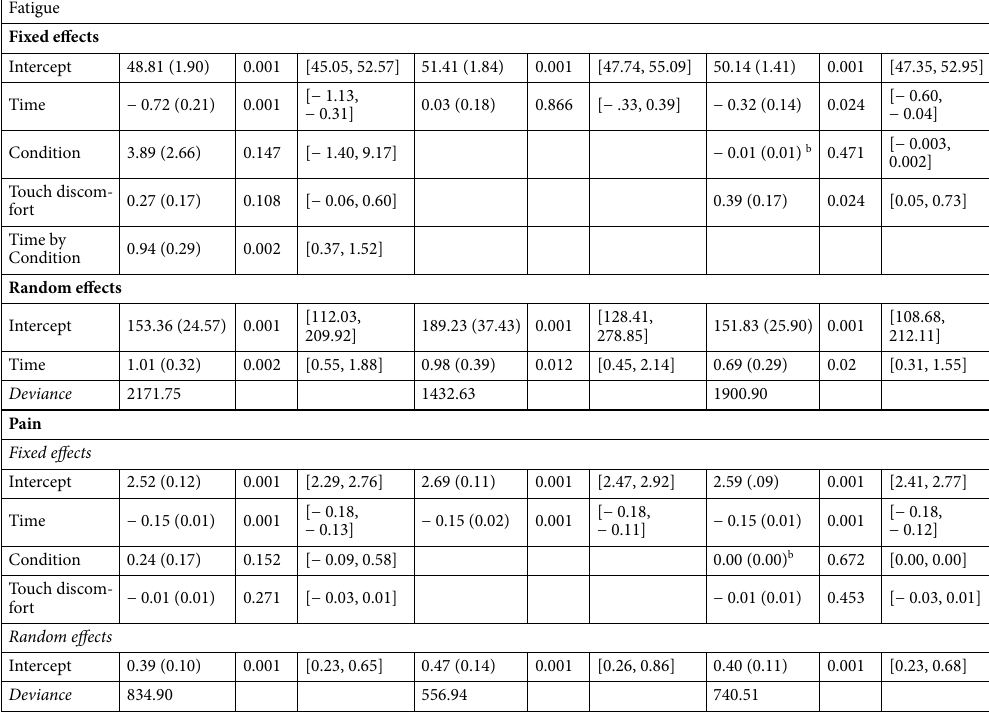
Table 4. Best fitting multilevel models predicting maternal fatigue and pain symptoms from week 2 to week 12 postnatally. a Condition: 0 = CAU; 1 = SSC. b Values are for dose variable rather than condition